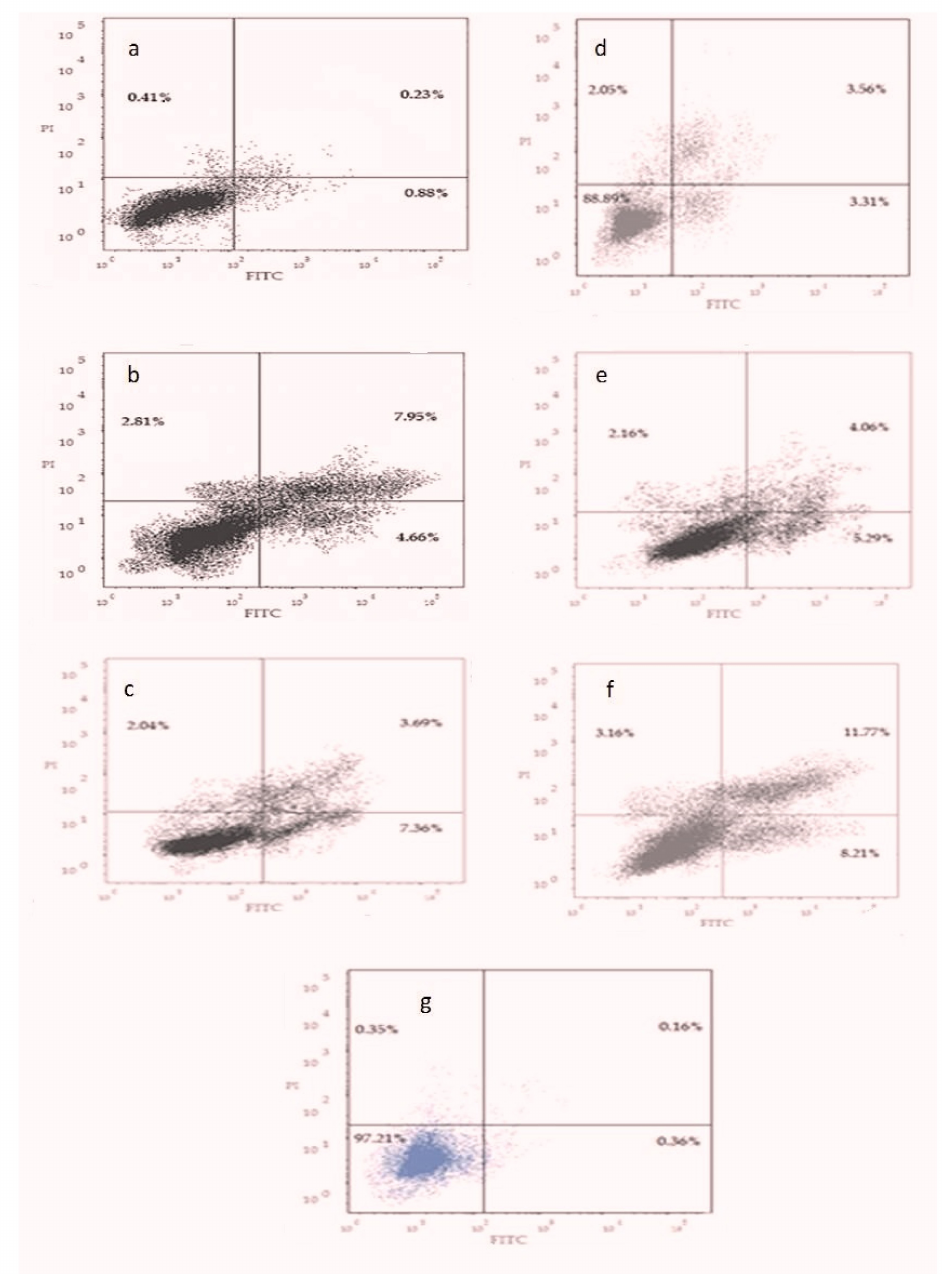
Figure 7. Annexin V-FITC and propidium iodide. A contour plot for cells treated with different concentrations of Propolis (half IC 50 of propolis ( a ), IC 50 of propolis ( b ), double IC 50 of propolis ( c )) or propolis-encapsulated liposome (half IC 50 of propolis-encapsulated liposome ( d ), IC 50 of propolis-encapsulated liposome ( e ), and double IC 50 of propolis-encapsulated liposome ( f )), and control cells ( g